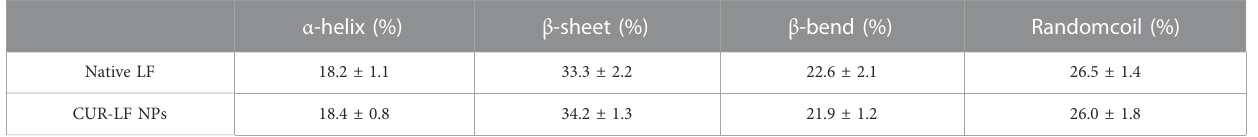
TABLE 1 Secondary structural contents of native lactoferrin and CUR-LF NPs. Data were presented as mean ± SD (n = 3). α -helix (%) β -sheet